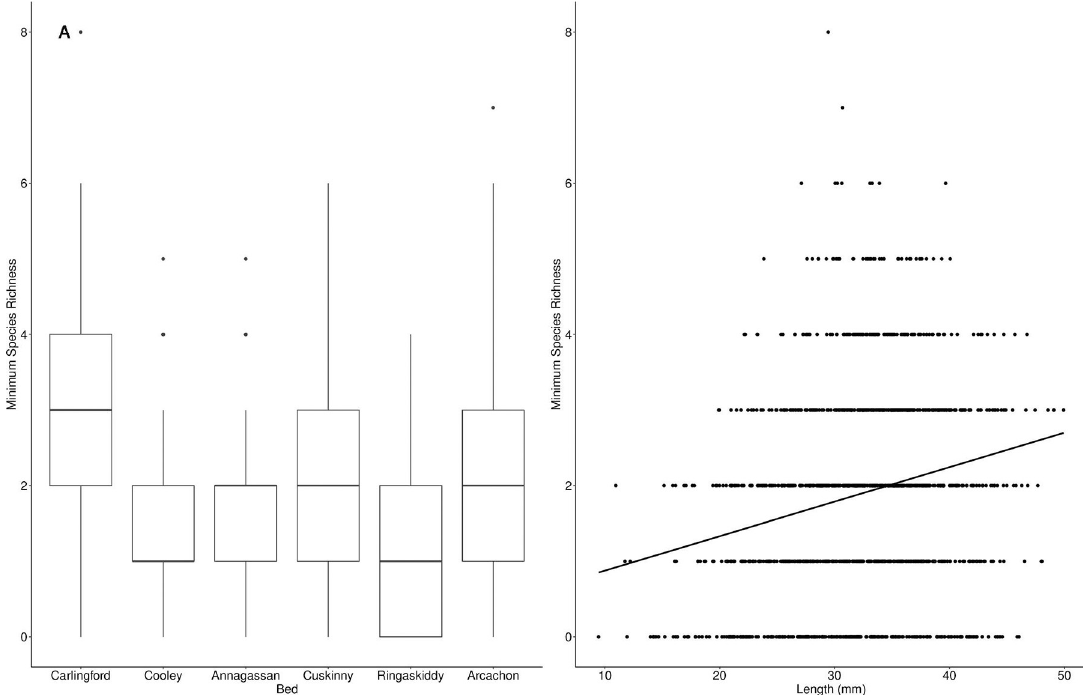
Fig 2. Relationships between minimum parasite species richness (not all identified to species level) and (A) cockle beds and (B) cockle length, between April 2018 and October 2019. Boxplots in (A) demonstrate the median values, boxes extend from the 25 th to 75 th percentile of each group’s distribution of values, and whiskers show the largest and smallest values within 1.5 times the interquartile range. Outliers are indicated by individually plotted points.